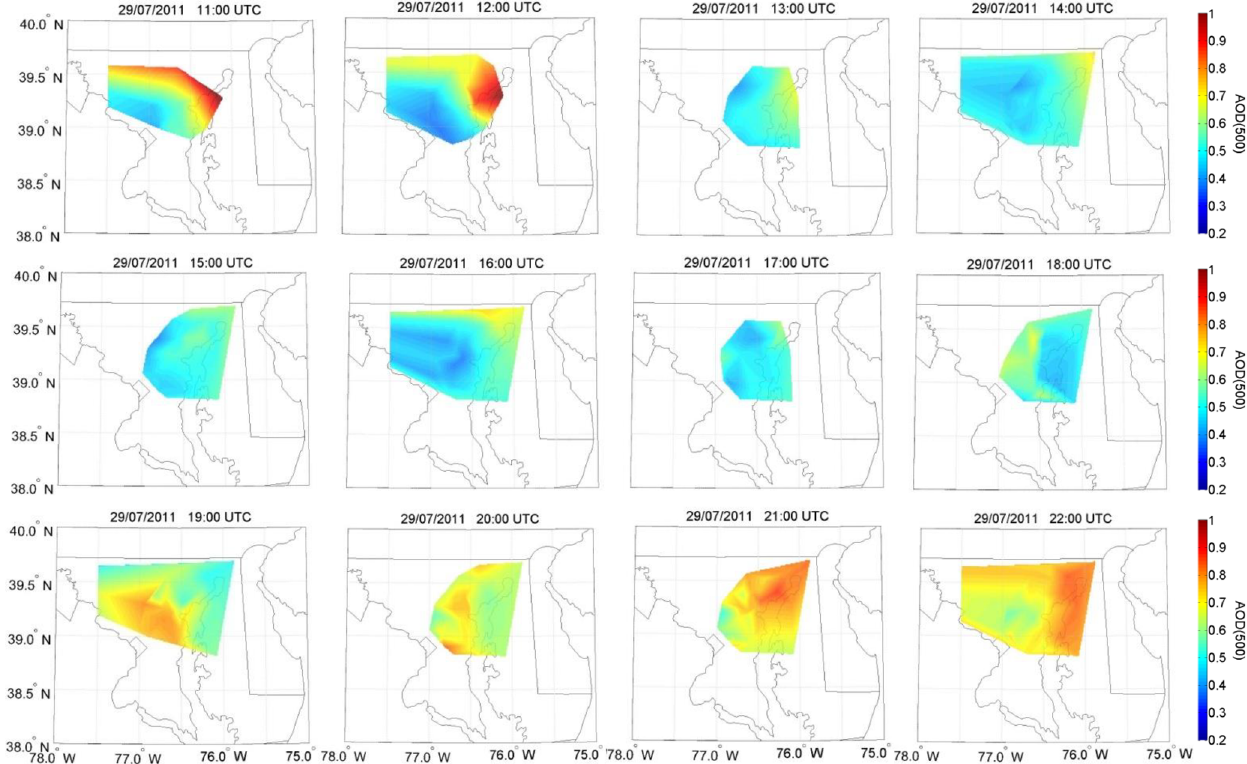
Figure 14. Temporal evolution of AOD at 500nm from AERONET-DRAGON over the Baltimore–Washington DC area on 29 July